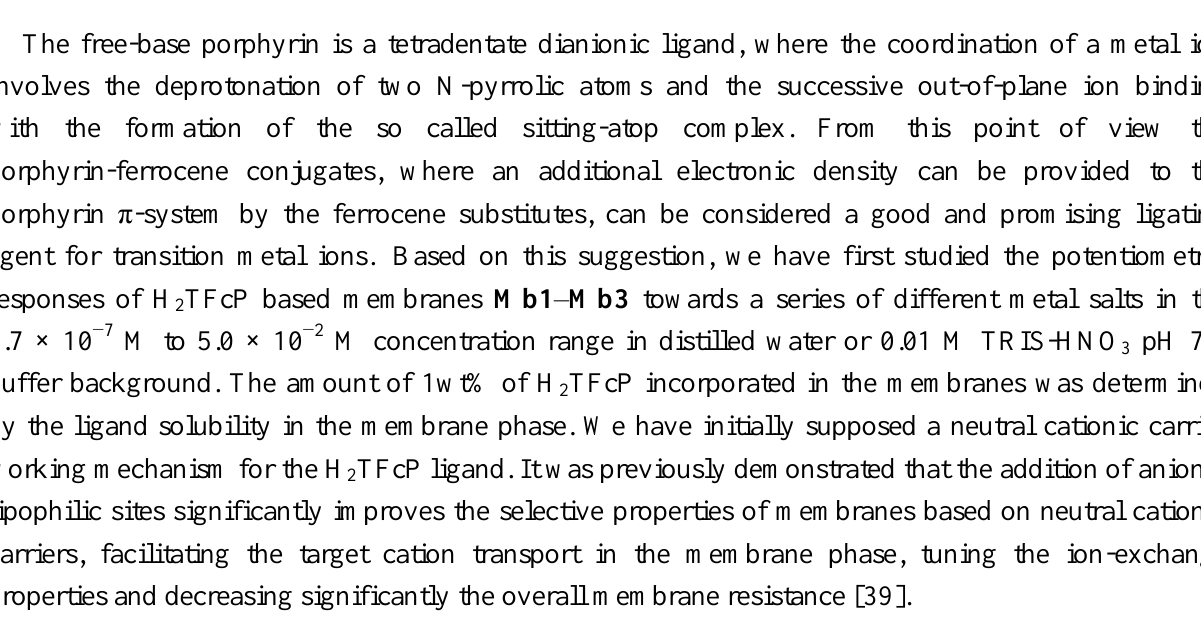
TFcP-based membranes towards several 2